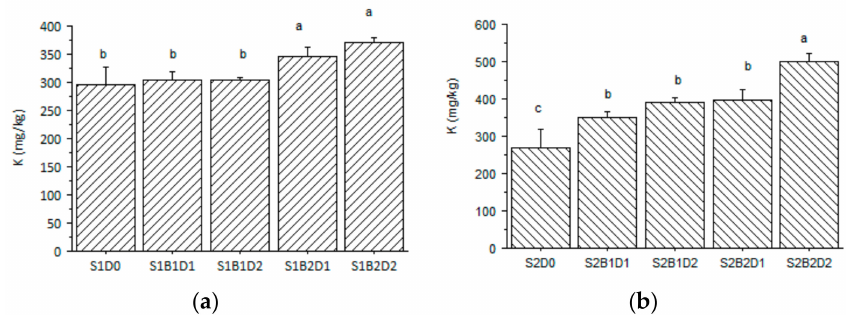
Figure 4. Main value and standard deviation of K concentration in two di ff erent growing media with a di ff erent application rate of biochar. ( a ) K concentration in the sandy-loam growing substrate—S1, ( b ) K concentration in the clay-loam substrate—S2; B1: biochar produced at 400 ◦ C; B2: biochar produced at 600 ◦ C; D1: 1.5 wt. %; D2: 3 wt. %). Di ff erent letters indicate significant di ff erences ( p <